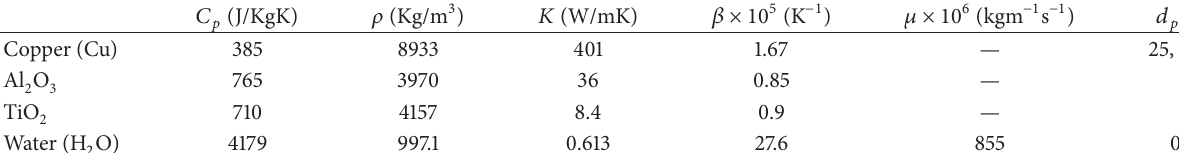
Table 1: Thermophysical properties of water and nanoparticles at 𝑇 = 300 K [14].